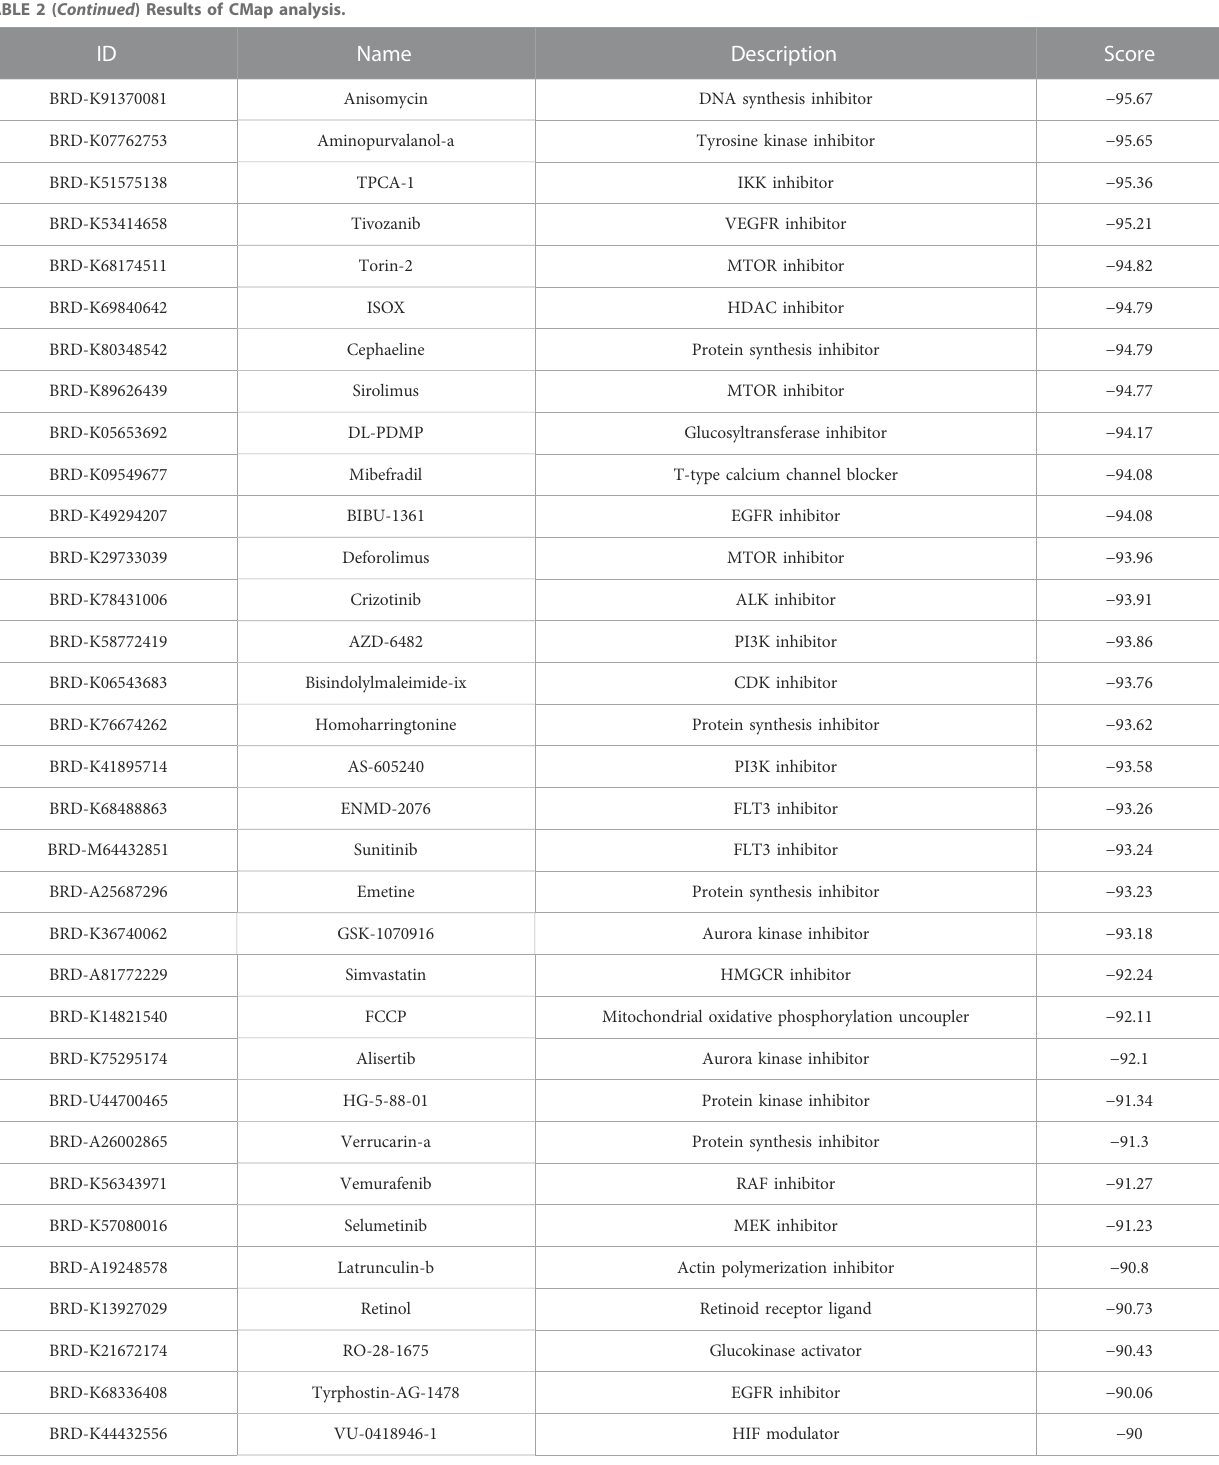
protein ubiquitination. KEGG analysis revealed that DURGs were functionally involved in ubiquitin-mediated proteolysis, Fc γ r-mediated phagocytosis, and proteasome and NF-kappa B signaling pathways. In addition, among the eight genes, RBBP4, CBX4, TRAIP, and USP14 speci fi cally bind to substrate proteins. According to the functional analysis of substrate proteins,